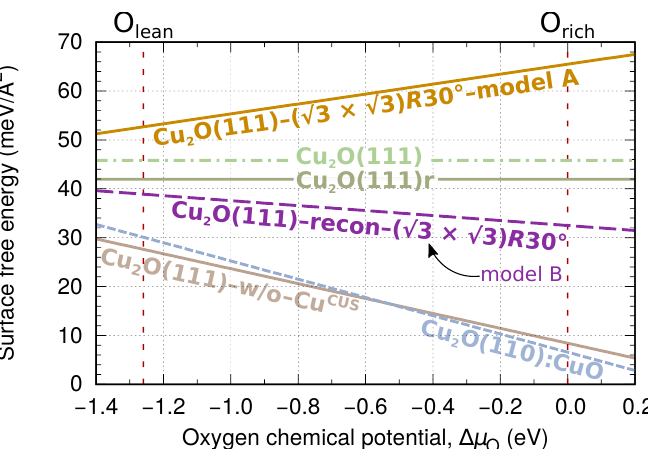
√ √ 3 × 3) R 30 ◦ reconstructed Cu 2 O(111)